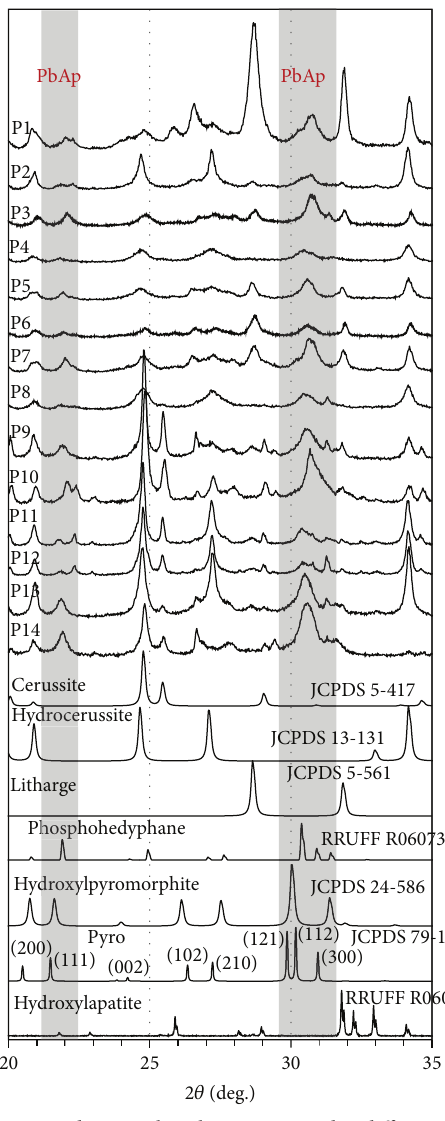
Figure 2: Lead mineral scale. X-ray powder diffraction patterns of lead pipes P1–P14 together with published reference spectra of oxide,carbonate,andphosphatemineralstakenfromtheJCPDSand RRUFF databases. The prominent apatite peaks are shaded and the pattern for pyromorphite is